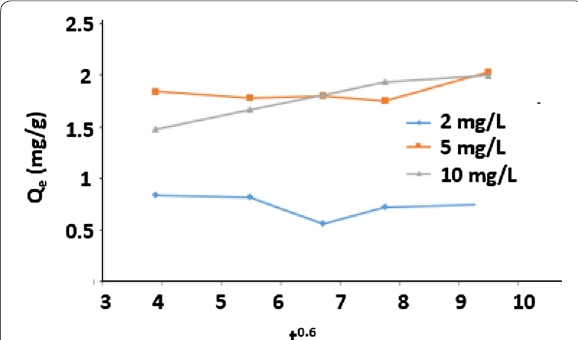
Fig. 15 Intraparticle diffusion model (Weber–Morris) for As (III) at 2, 5 and 10 mg/L